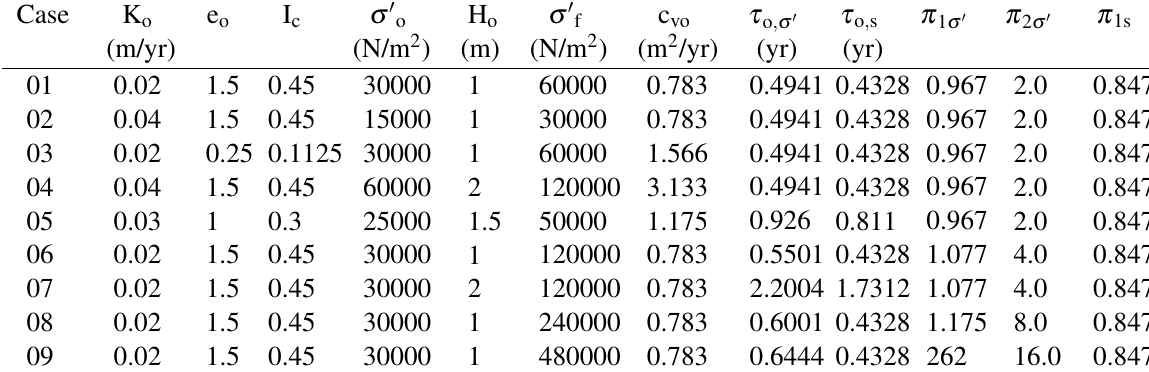
Table 3 Verification of the dimensionless groups for the extended Davis and Raymond model with both non-constant c v and 1+e and variable d z .